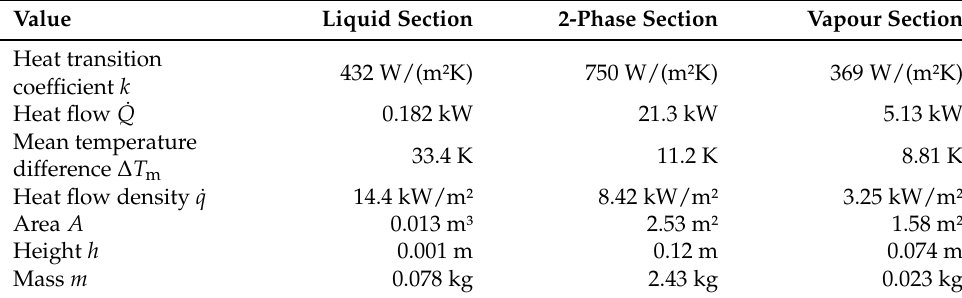
Table A3. Results modelling the HP condenser.